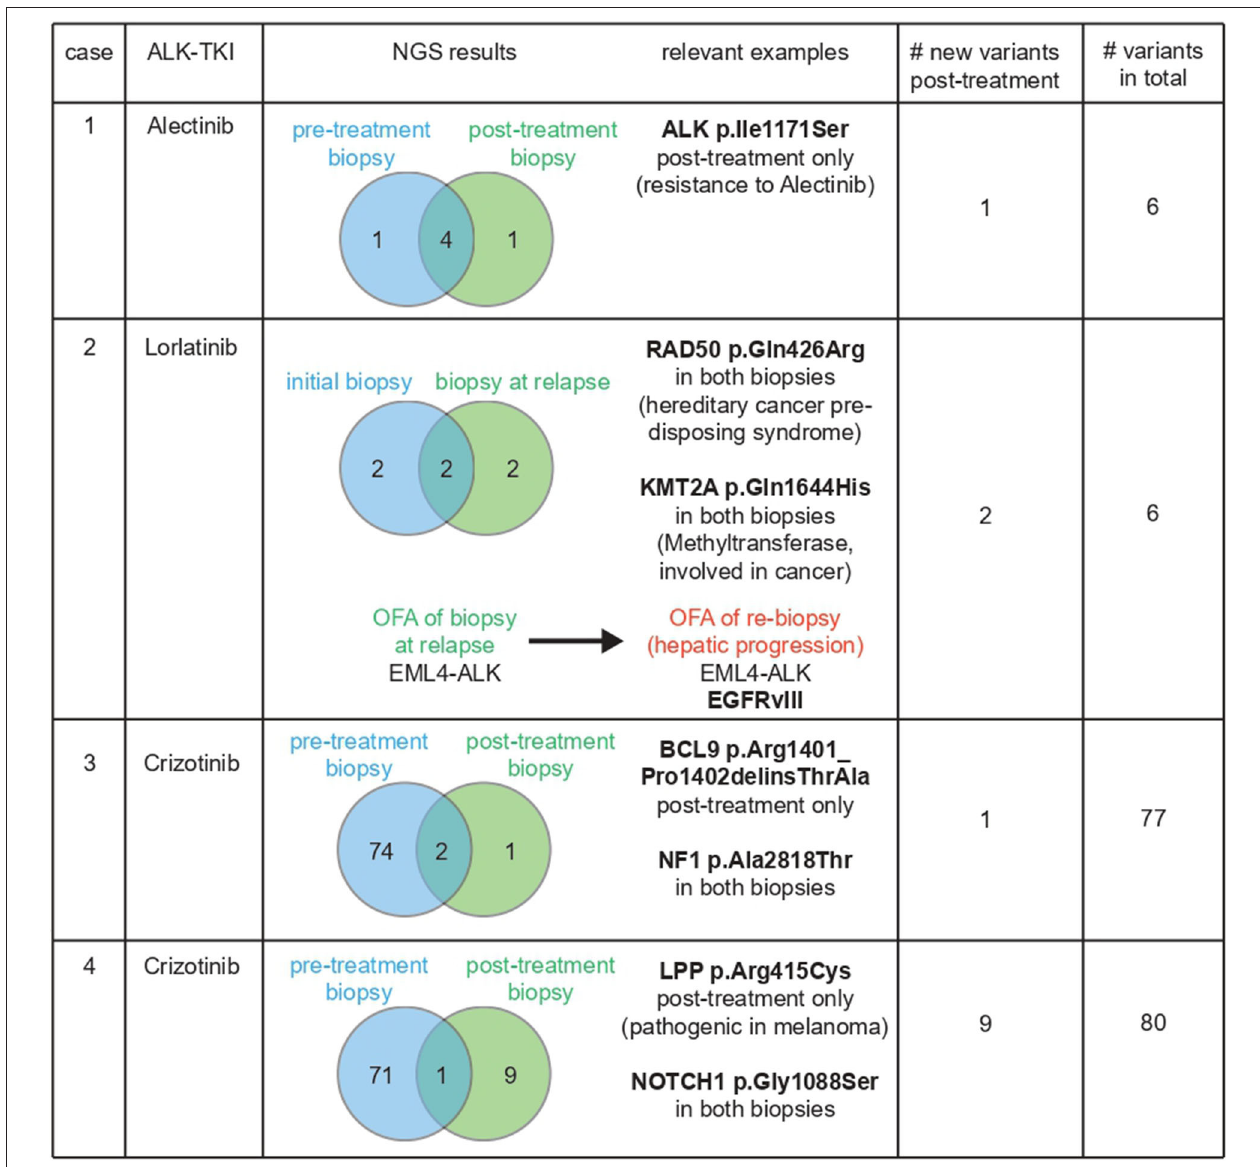
FIGURE 2 | Summary of molecular aberrations in pre- and post-treatment biopsies.